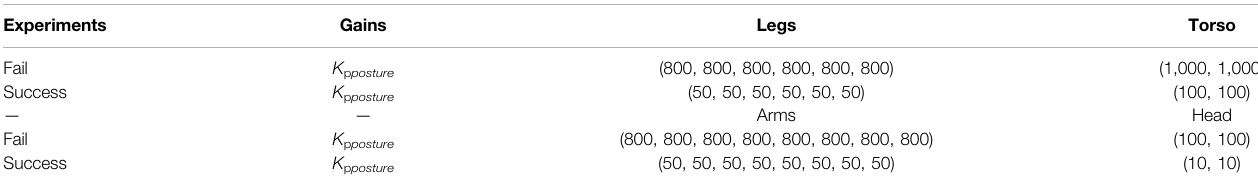
TABLE 10 | Task gains of the torque control scheme for the posture task.